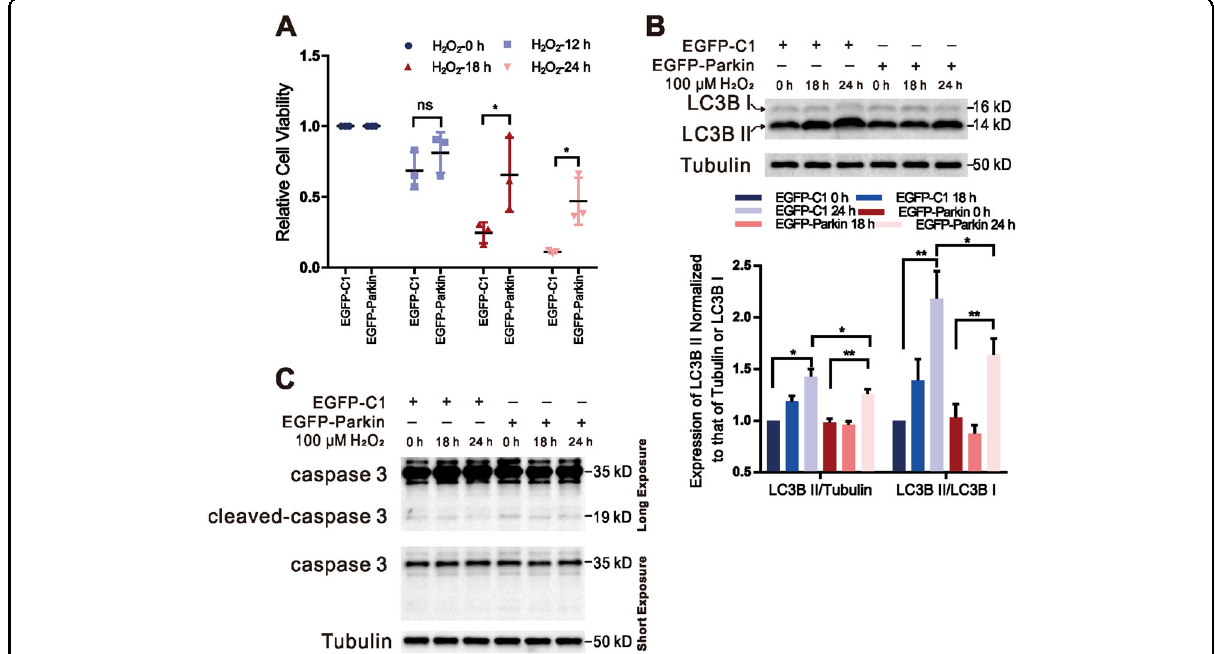
Fig. 6 Parkin-mediated mitophagy restrains H 2 O 2 -induced cell death. A Cells were transfected with EGFP-C1 or EGFP-Parkin plasmids. Twenty- four hours later, cell viability was detected after H 2 O 2 induction (100 μΜ ; 0 h, 12 h, 18 h, or 24 h). N = 3; ns, not signi fi cant; * P < 0.05. Data from three independent tests were collected for statistical analysis (mean± SD). B Cells were transfected with EGFP-C1 or EGFP-Parkin and then stimulated with 100 μΜ H 2 O 2 for 0 h, 18 h, or 24 h. The levels of the autophagy marker LC3B were evaluated by WB analysis. Tubulin was used as an endogenous control. N = 3; * P < 0.05; ** P < 0.01. The data are from three independent tests and are presented as the mean ± SD. C Cells were transfected with EGFP-C1 or EGFP-Parkin plasmids. Twenty-four hours later, the cells were treated with 100 μΜ H 2 O 2 for 0 h, 18 h, or 24 h. The levels of caspase 3 and cleaved caspase 3 were evaluated by WB analysis. The upper band underwent a long exposure, and the lower band underwent a short exposure. Tubulin was used as an internal